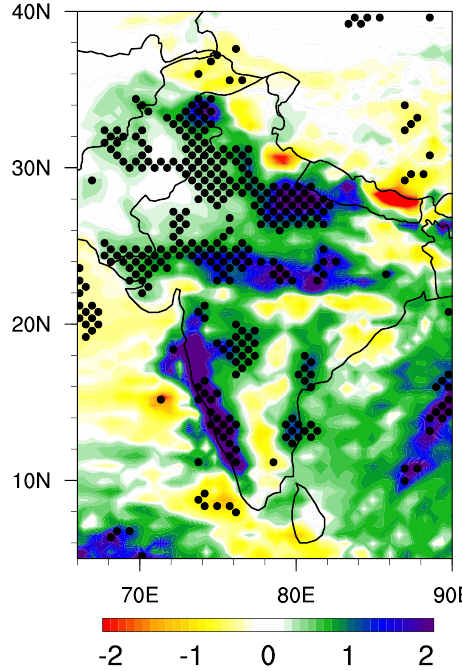
Figure 7. The spatial correlation coefficients between the regressed rainfall change pattern (Figure 5c) and the modeled rainfall re- sponse (Fig. 6) in (a) each ensemble member (marked by numbers from 1 to 16), their ensemble mean (marked by “EM”), and (b) the ensemble means of several subgroups of the ensemble members. “EM” stands for the ensemble mean of all ensemble members. In (b) , “PB1” and “PB8” indicate the ensemble means of the ensem- ble members in which PBL option 1 and 8 are used, respectively. “SW2” and “SW4” indicate the ensemble means of the ensemble members in which SW option 2 and 4 are used, respectively. “OP1”, “OP2”, “OP3”, and “OP4” indicate the ensemble means of the en- semble members in which aerosol chemical mixing rules 1, 2, 3, and 4 are used, respectively. The region for calculating the spatial correlation is WHI. Using other figures in Fig. 5 for the evaluations gets similar results. See Table 2 for the